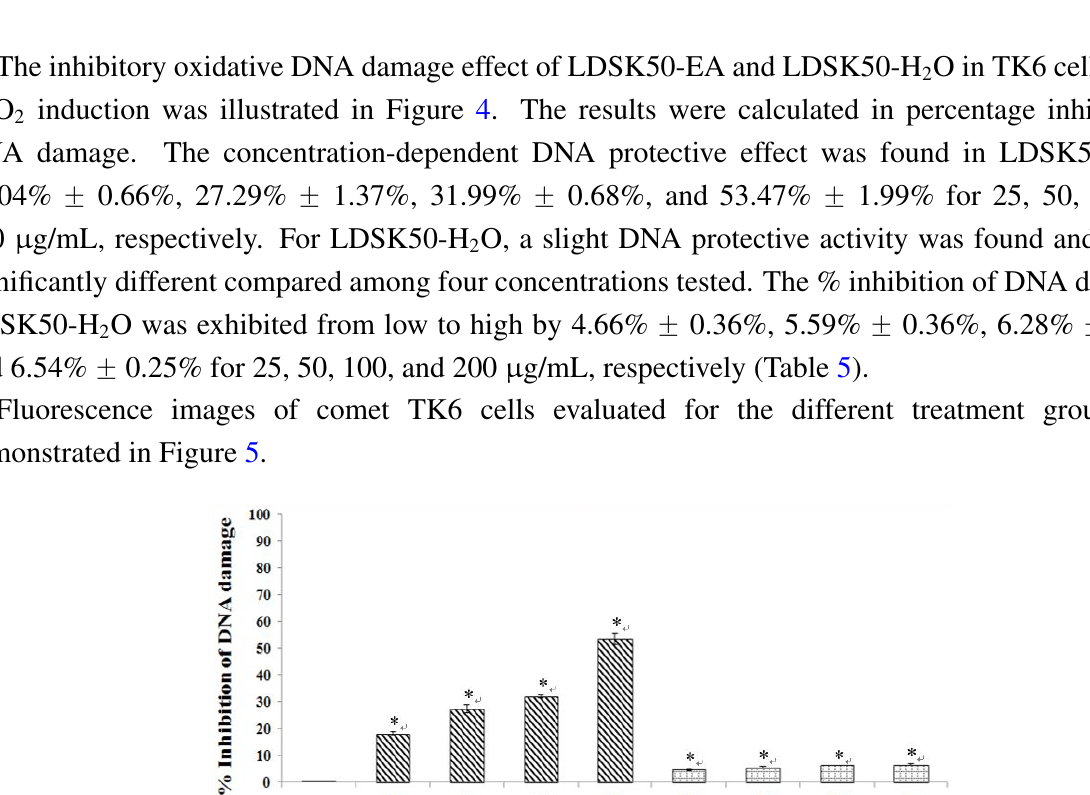
Figure 3. Tail moment (TM, %) values measured in pre-treated TK6 cells with LDSK50-EA (fractions of 50% ethanol extract of the L. domesticum skin followed by ethyl acetate (EA) fractionation) and LDSK50-H 2 O (the aqueous phase product when the L. domesticum skin was extracted with 50% aqueous ethanol and partitioned with EA) fractions followed by H 2 O 2 damage induction by comet assay. Results were expressed as means ± standard deviation (SD) ( n = 3). * Significant difference was detected from 50 µM H 2 O 2 treatment groups at p ≤ 0.05.